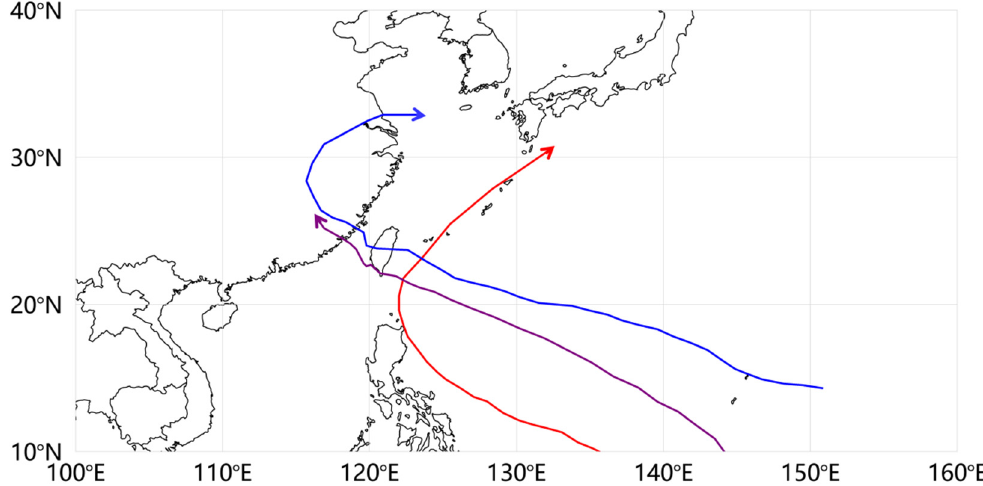
Figure 14. The tracks of typhoon Noul (red line), Soudelor (blue line), and Nepartak (purple line). Table 17. Skill scores of the wind speed, wind direction, and significant wave height obtained from the best simulation experiments for typhoons Noul, Soudelor, and